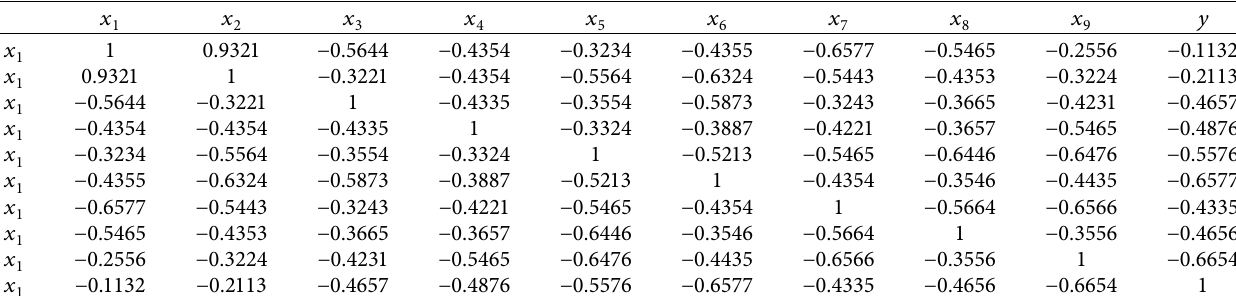
Table 2: The correlation values between the price factors and gold price for the whole data